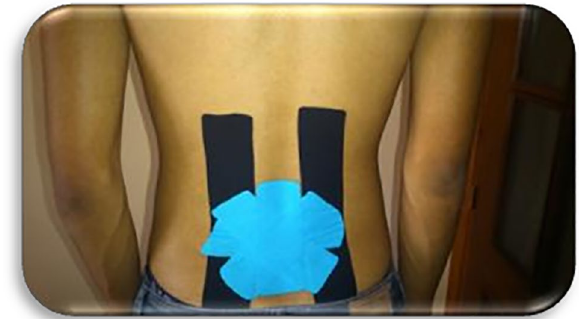
Figure 2. Space correction technique with kinesio